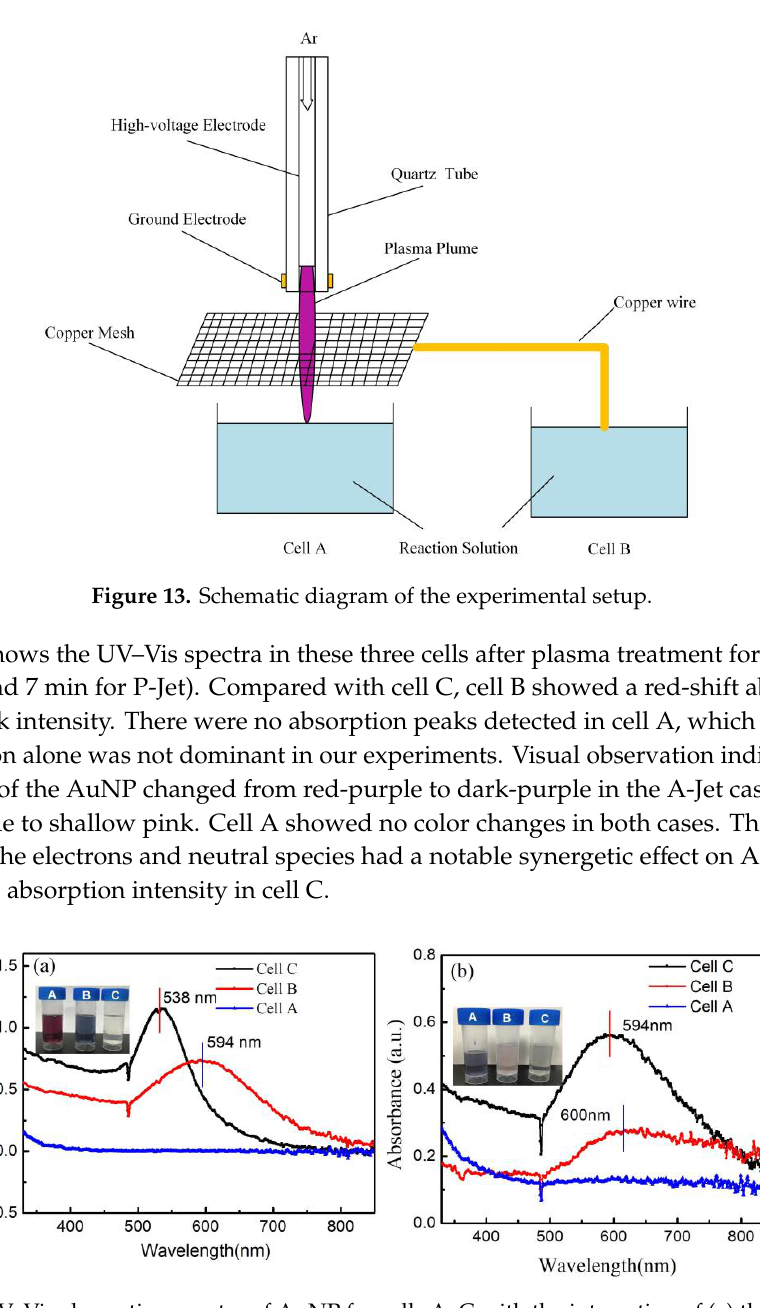
Figure 14. UV–Vis absorption spectra of AuNP for cells A–C with the interaction of ( a ) the A-Jet and ( b ) the P-Jet (A, B, and C in the vials stands for Cell A, Cell B and Cell C).